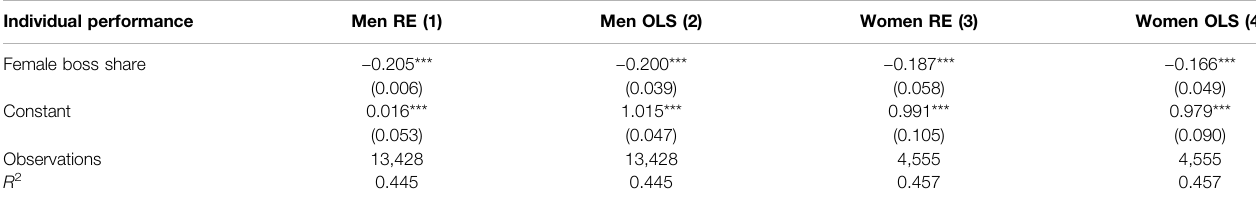
TABLE 8 | Random-effects and ordinary least squares regression results for linear downward- fl owing effects for men and women. Individual